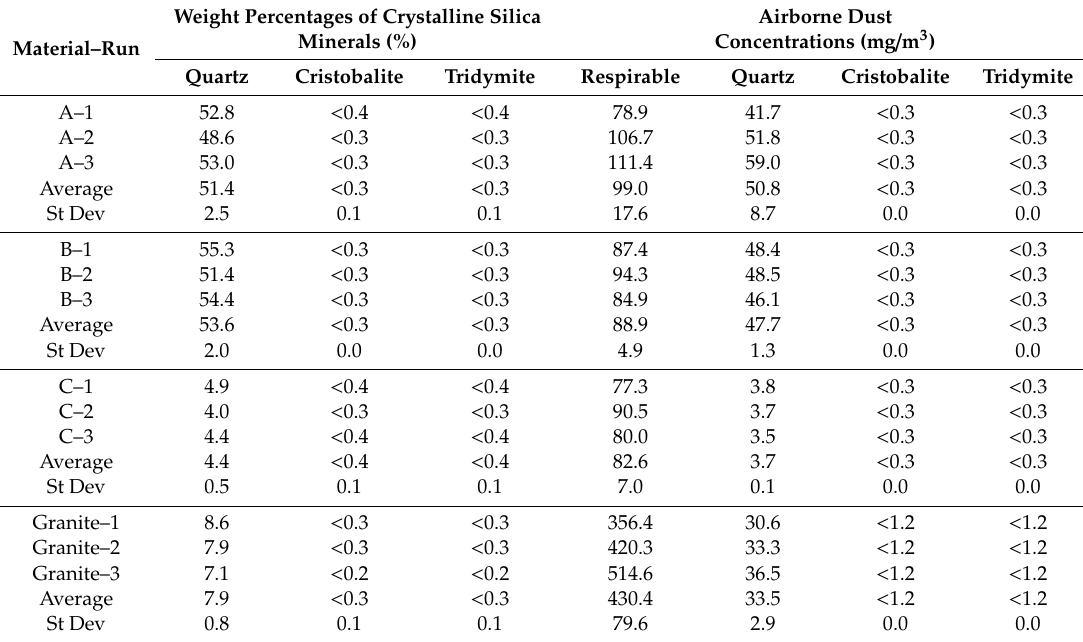
Table 3. Summary of average particle concentrations on polyvinyl chloride filters by number and mass and particle chemistry analysis by weight and number percent. StDev, standard